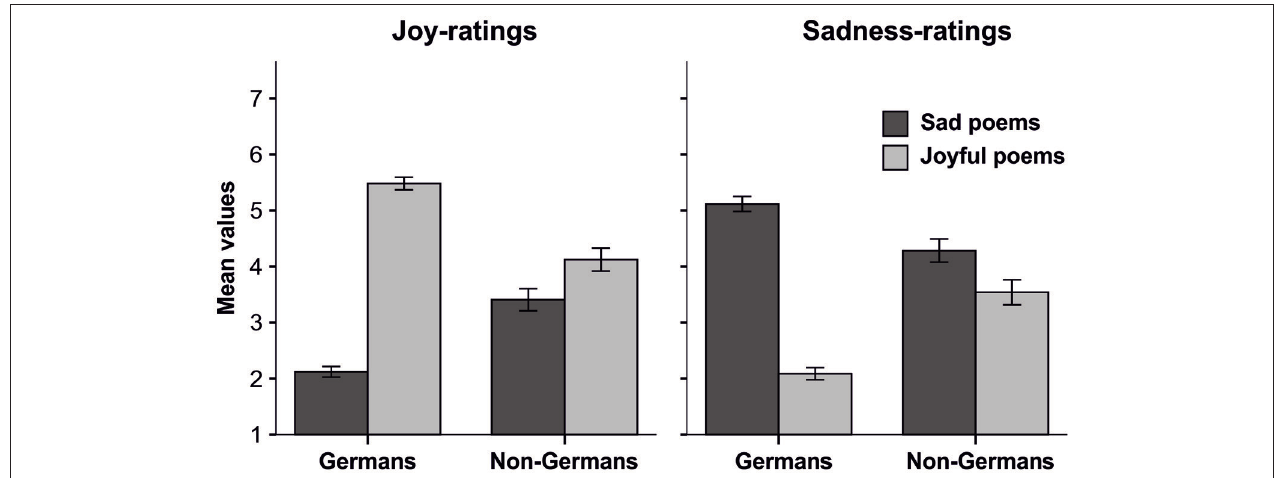
FIGURE 2 | Bar charts showing mean values of Joy and Sadness- ratings from German and non-German speaking participants, separately displayed for joyful and sad poems. Error bars indicate the 95% confidence intervals.